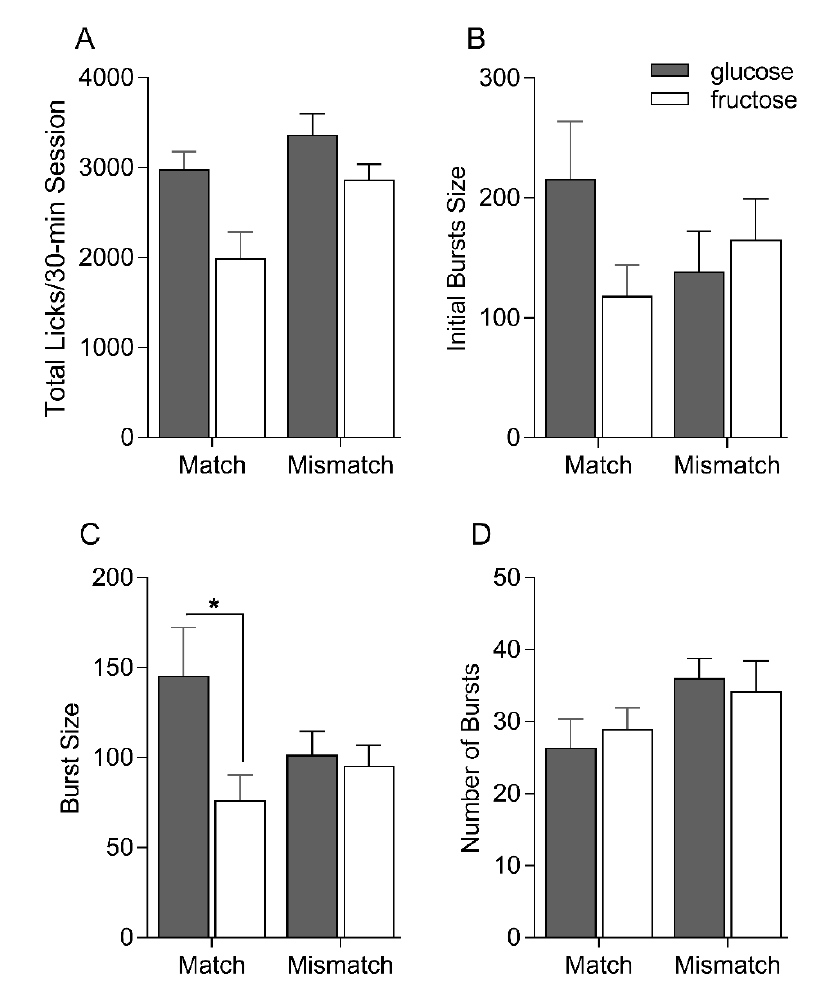
Figure 2. Mean ± SEM total licks ( A ), initial bursts size ( B ), overall burst size ( C ) and overall number of bursts ( D ) on the post-conditioning single-bottle 0.56 M glucose and fructose intake test sessions for Matched and Mismatched groups. Significant differences indicated by asterisks (*).